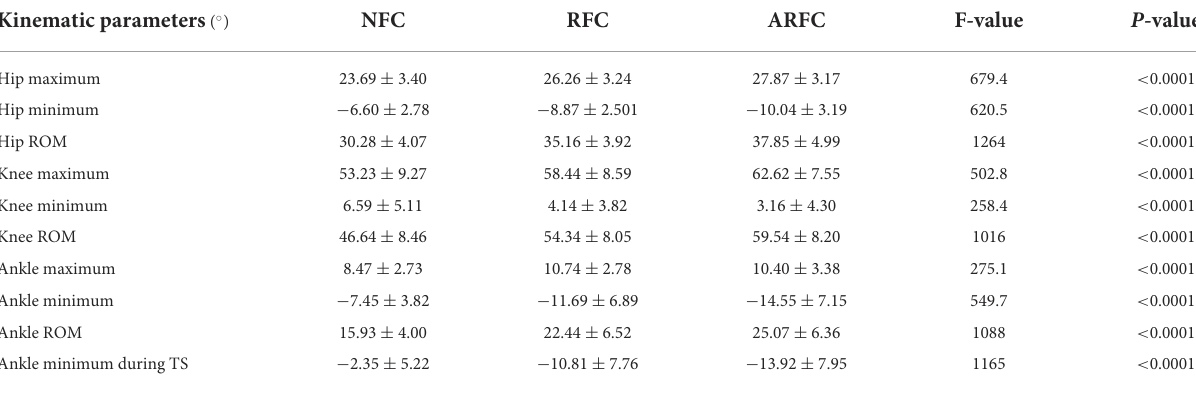
TABLE 3 Effects of stimulation condition on joint kinematic parameters using one-way analysis of variance (ANOVA). Kinematic parameters ( NFC RFC ◦ )